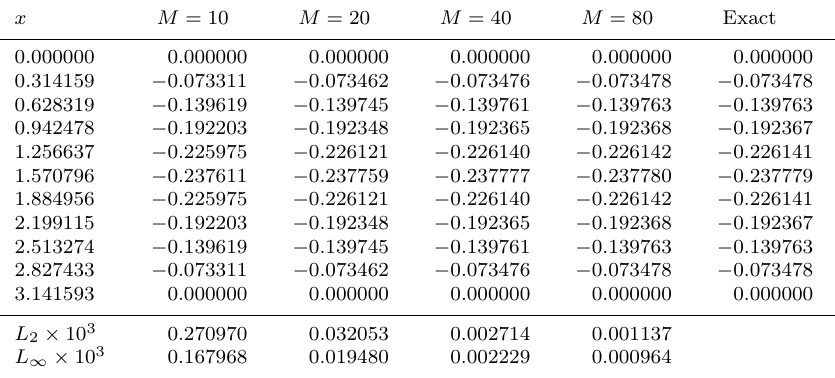
Table 6. The comparison of solutions and error norms of the diffusion-wave problem for γ = 1 . 5, ∆t = 0 . 0015 and t f = 3 .